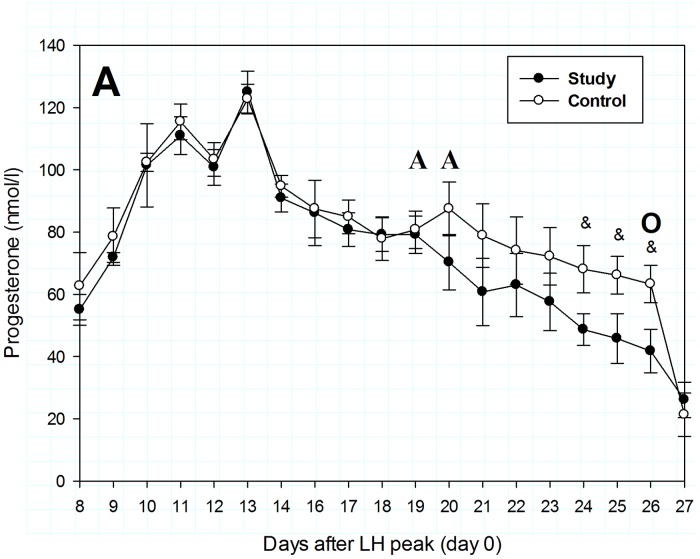
Serum progesterone concentrations in study (n = 9) and control (n = 5) bitches during the luteal phase, from days 8 to 27 after the estimated LH peak.The AA indicates days of treatment with aglepristone (10 mg/kg bw) or saline and O it is a day of ovariohysterectomy. Results are expressed as means ± SD. & and asterisks indicate values significantly different from controls (p<0.05 and p<0.01, respectively).